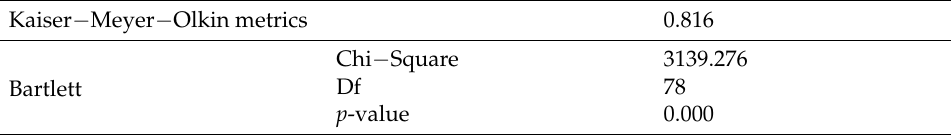
Table 3. KMO and Bartlett test results.